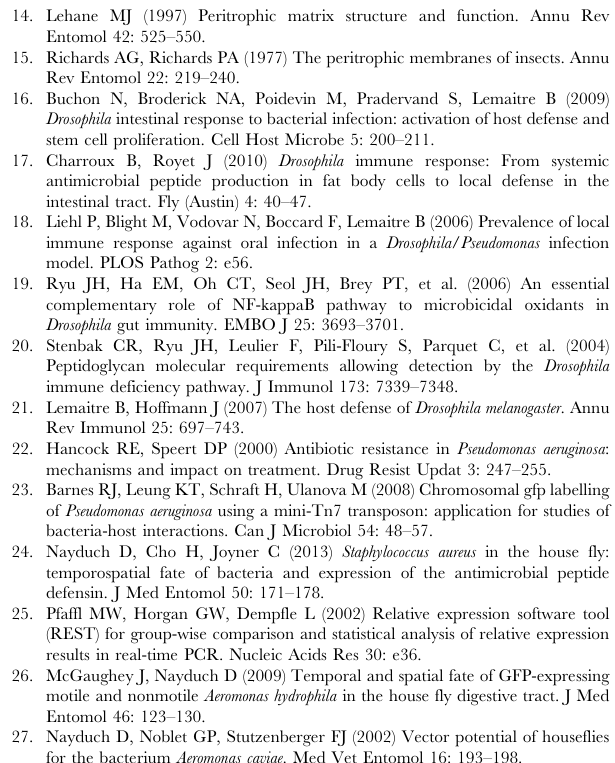
Table S1 Primer sequences used for qRT-PCR analyses of antimicrobial peptide gene expression in house flies fed GFP- P. aeruginosa . Table S2 Systemic and local antimicrobial peptide expression analysis using REST-MCS (cid:1) . House flies